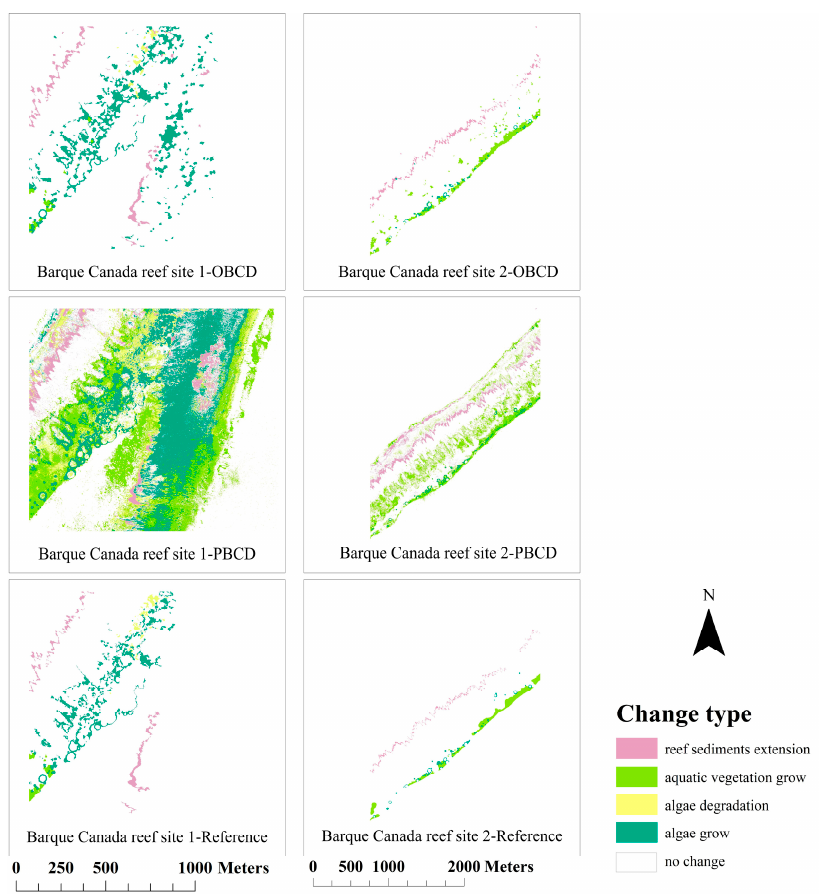
Figure 5. Change detection maps and reference maps of the two study sites on Barque Canada Reef.